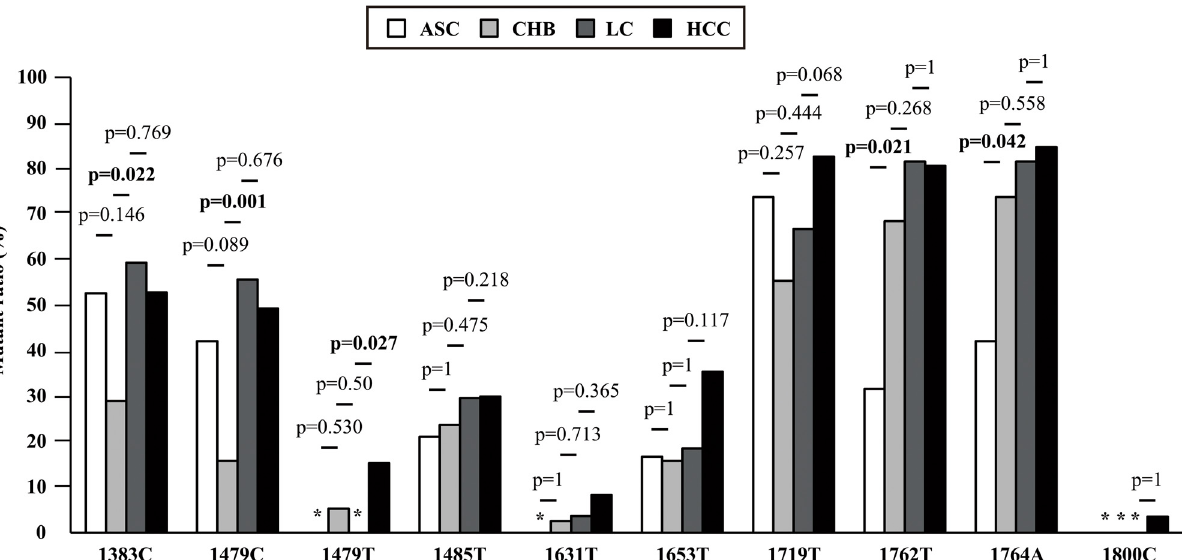
Fig 2. HCC risk mutations in genotype C sequences across different disease phases. We checked the distribution of HBV genotype C HCC risk mutations among sequences from different disease phases (ASC, 18; CHB, 38; LC, 27; HCC, 144). Those mutations showed characteristics among different phases: 1) except three mutations (1479T, 1631T, and 1800C) all the other mutations pre-existed in ASC, among which 1383C and 1719T were most pronounced. More than 50% ASC possessed either one of these two mutations and 42% ASC possessed both; 2) the frequency of four mutations (1485T, 1631T, 1762T, and 1764A) showed an increasing trend accompanied with the disease progression though the changes among groups were not significant (Jonckheere-Terpstra trend test, P > 0.05); and 3) ratios of 4 mutations (1383C, 1479C, 1479T, and 1719T) fluctuated among different disease phases. No mutants were observed in the cases denoted by